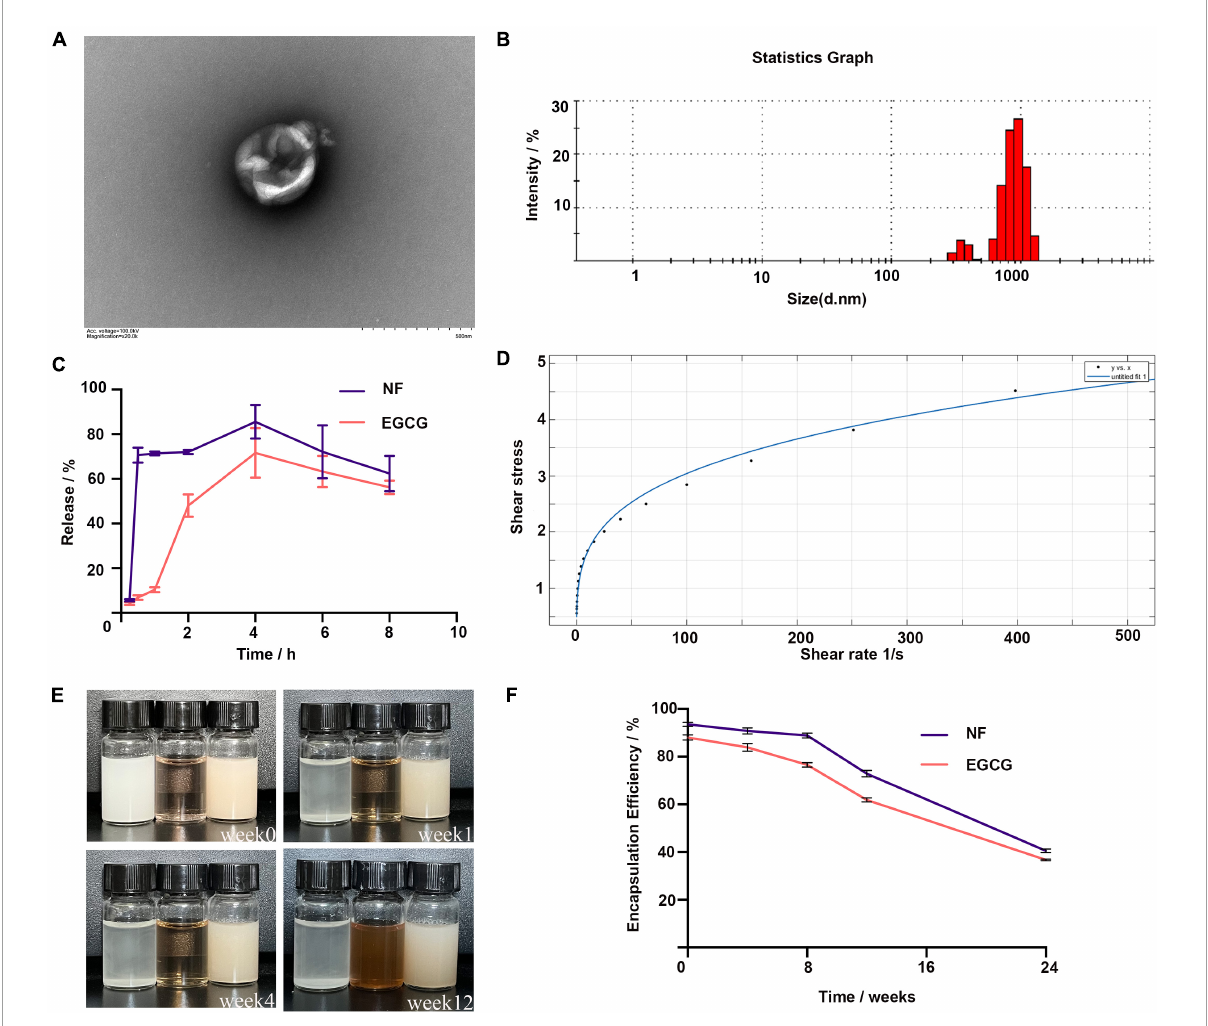
FIGURE1 Characterization of NFEG-microgel. (A) NFEG-microgel observed by TEM, (B) average particle size of NFEG-microgel, (C) simulated NFEG-microgel digestion in SGF and SIF, (D) rheological fitting curve, (E) storage of NFEG-microgel at 4 ◦ C for 12 weeks (from left to right, NF solution, EGCG aqueous solution, and NFEG were shown), and (F) encapsulation rates during storage for 24 weeks.